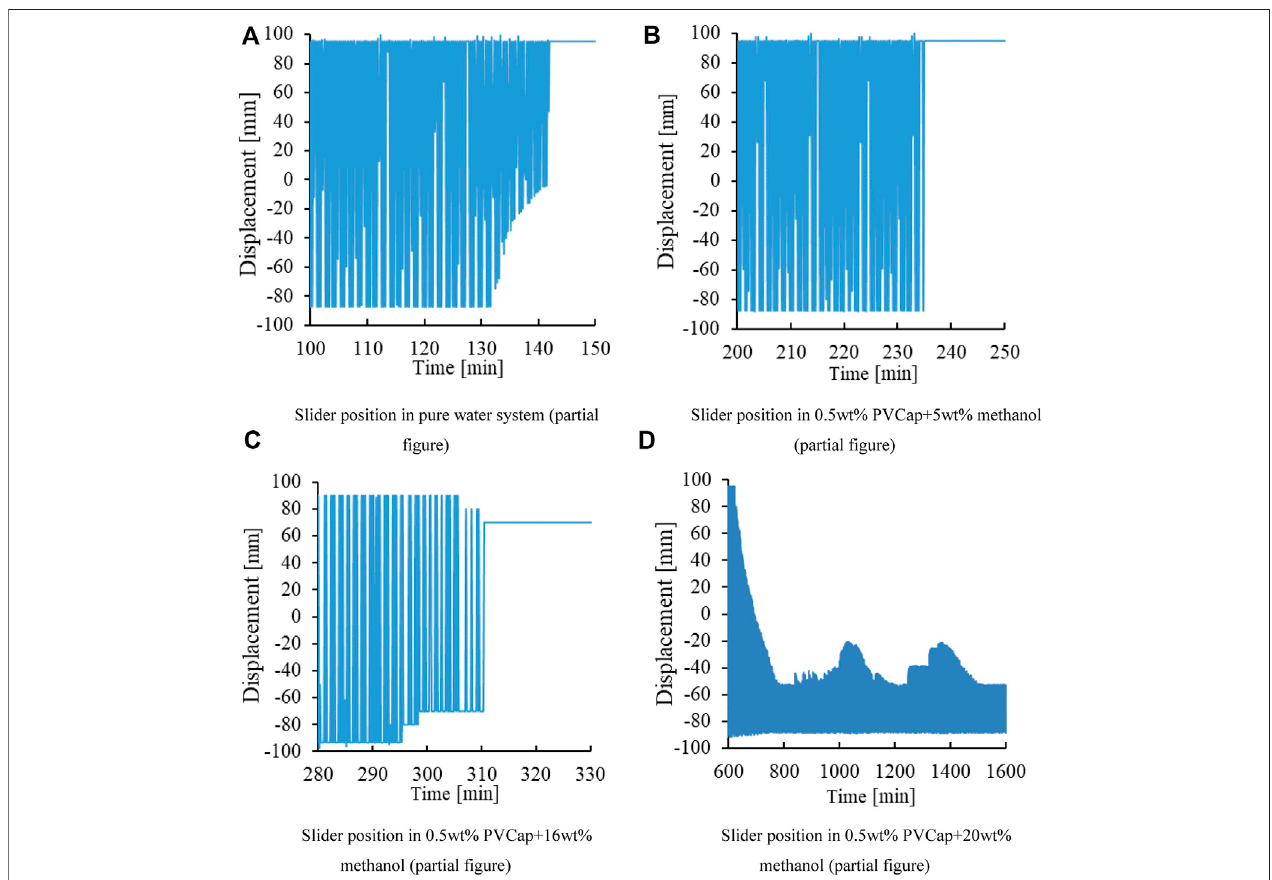
FIGURE 8 | Slider position in the PVCap and methanol combination system. (A) Slider position in the pure water system (partial fi gure). (B) Slider position in 0.5wt% PVCap+5wt%methanol(partial fi gure). (C) Sliderpositionin0.5wt%PVCap+16wt%methanol(partial fi gure). (D) Sliderpositionin0.5wt%PVCap+20wt%methanol(partial fi gure).